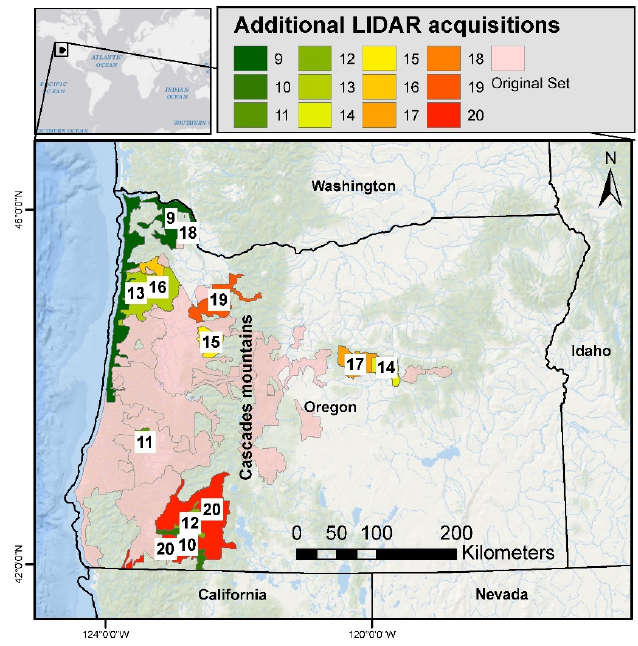
Figure A1. Predictors included in the semiparametric models and variable importance as percent reduction in mean.